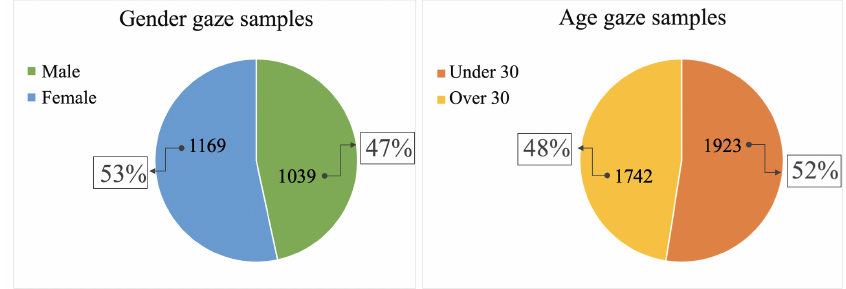
Figure 3. Distribution of data samples with respect to the two classification